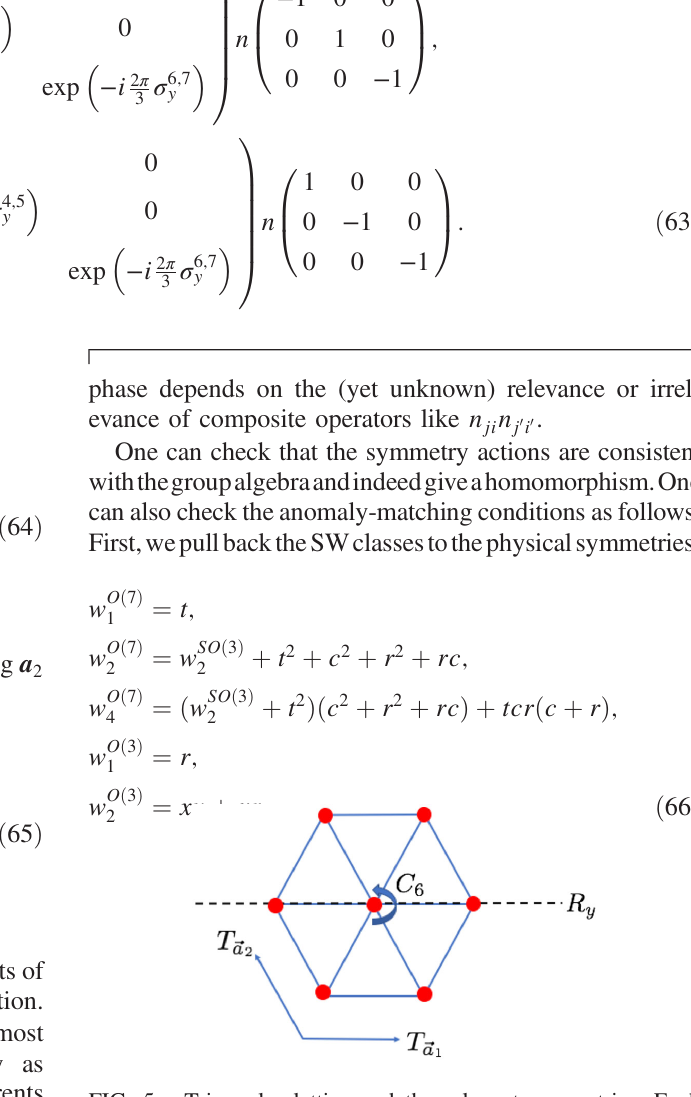
FIG. 5. Triangular lattice and the relevant symmetries. Each filled red circle represents an odd number of spin- 1 = 2 ’ s. The C 6 rotation is around a site that host the spins, and the dashed line is the reflection axis of R y